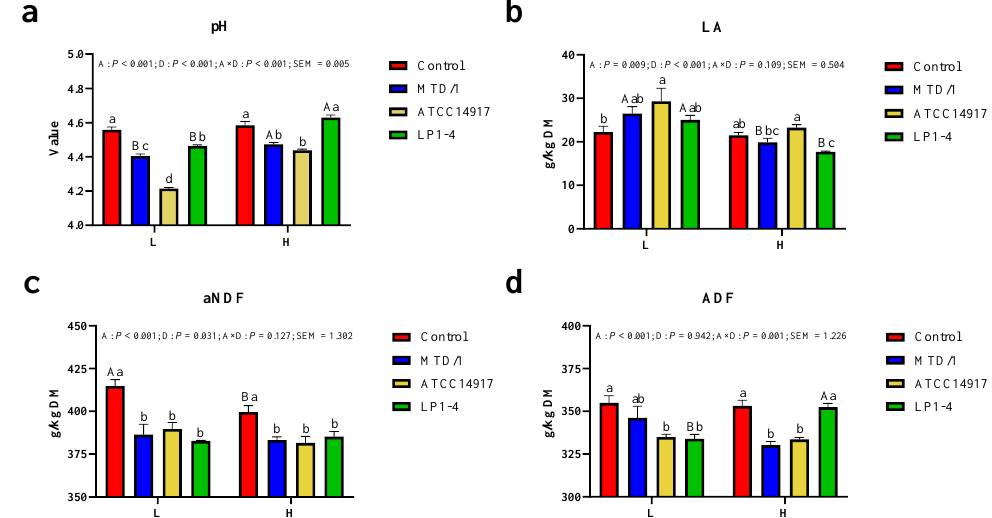
Figure 1. Lactic acid fermentation characteristics and fiber contents of alfalfa silages at moderate and high DM contents after 90 days. ( a ) PH, ( b ) LA, ( c ) aNDF, and ( d ) ADF. LA, lactic acid; aNDF, neutral detergent fiber analyzed with heat-stable α -amylase; ADF, acid detergent fiber; DM, dry matter. a–d: Different lowercase letters indicate significant differences among treatments in the same DM level ( p < 0.05). A–B: Different capital letters indicate significant differences between DM levels in the same treatment ( p <